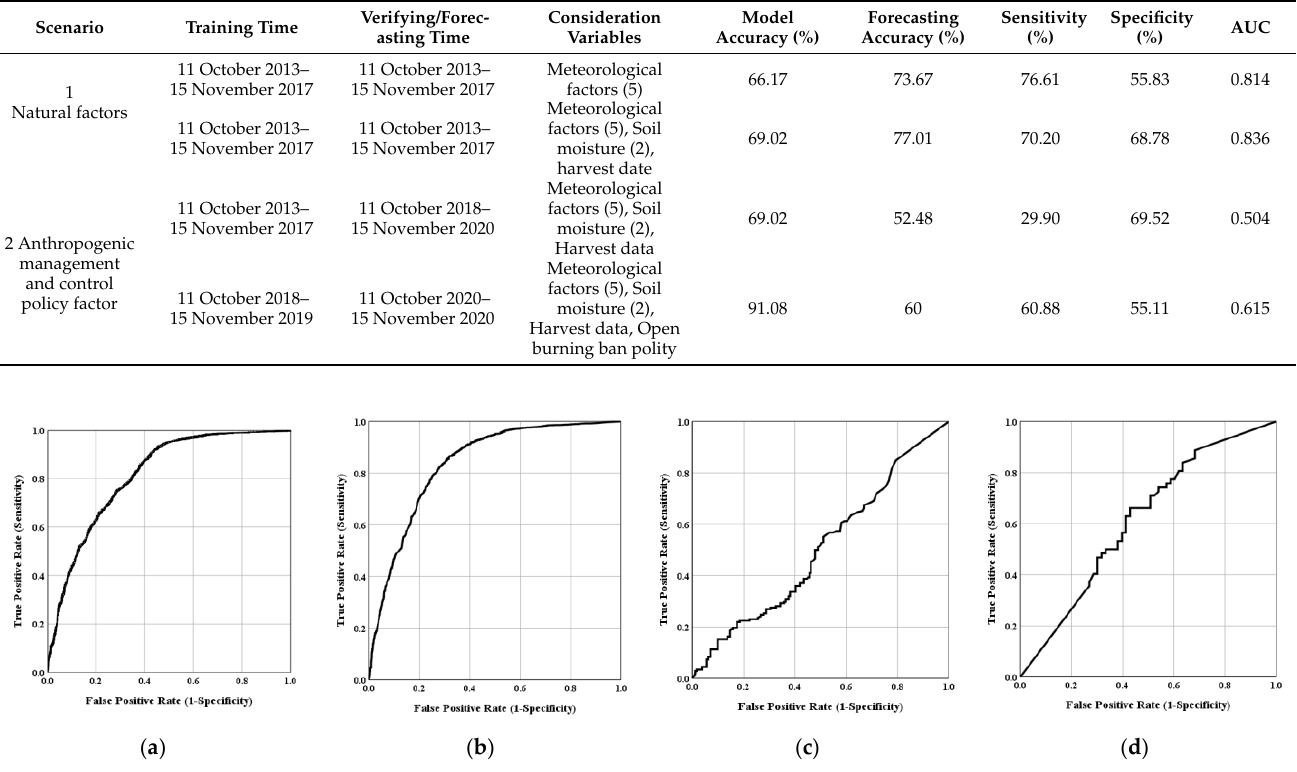
Figure 4. ROC curves of each model in the two scenarios, ( a ) the model of preliminary construction used meteorological factors in Scenario 1, ( b ) the model of optimized that contained 8 natural factors in Scenario 1, ( c ) the model of the first study in Scenario 2, ( d ) the model of optimized which added the anthropogenic management and the control policy factor in Scenario 2.